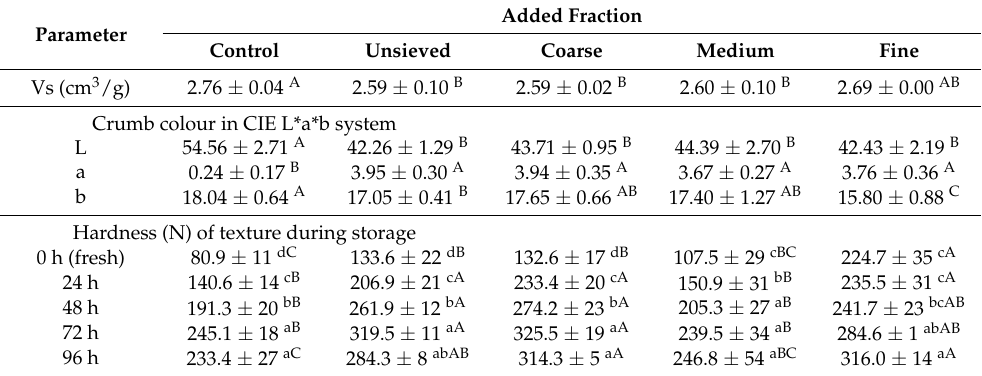
Table 5. Specific volume, crumb colour and texture analysis of the control bread and breads fortified with different milk thistle oilseed cake flour fractions.